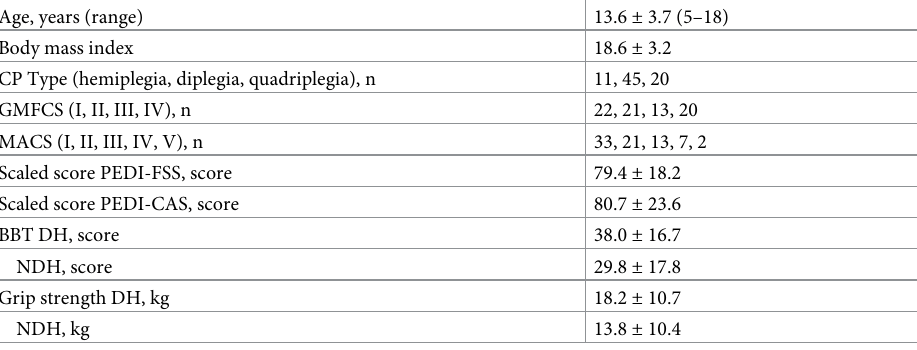
Table 1. Attributes of the participants and the measurement